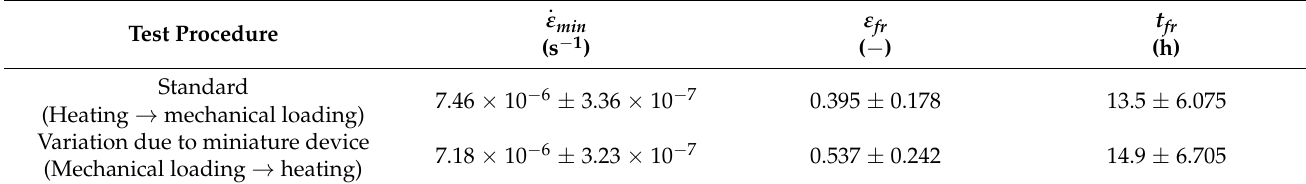
Table 3. Creep parameters of preliminary creep